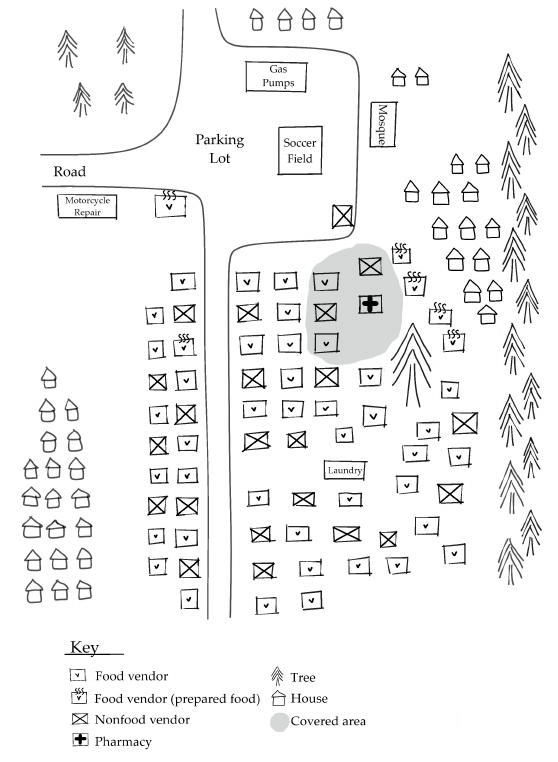
Figure 2. Map of large market on the periphery of a village. Combination of prepared and unprepared food items. High volume of vendors.